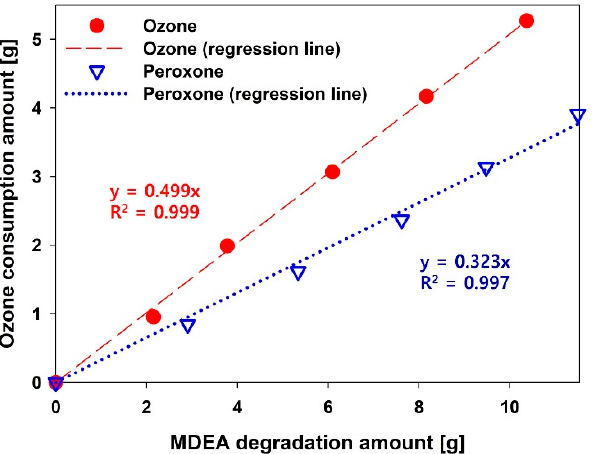
Figure 4. Actual ozone consumption to MDEA degradation ratio in the ozone and peroxone pretreatment tests.